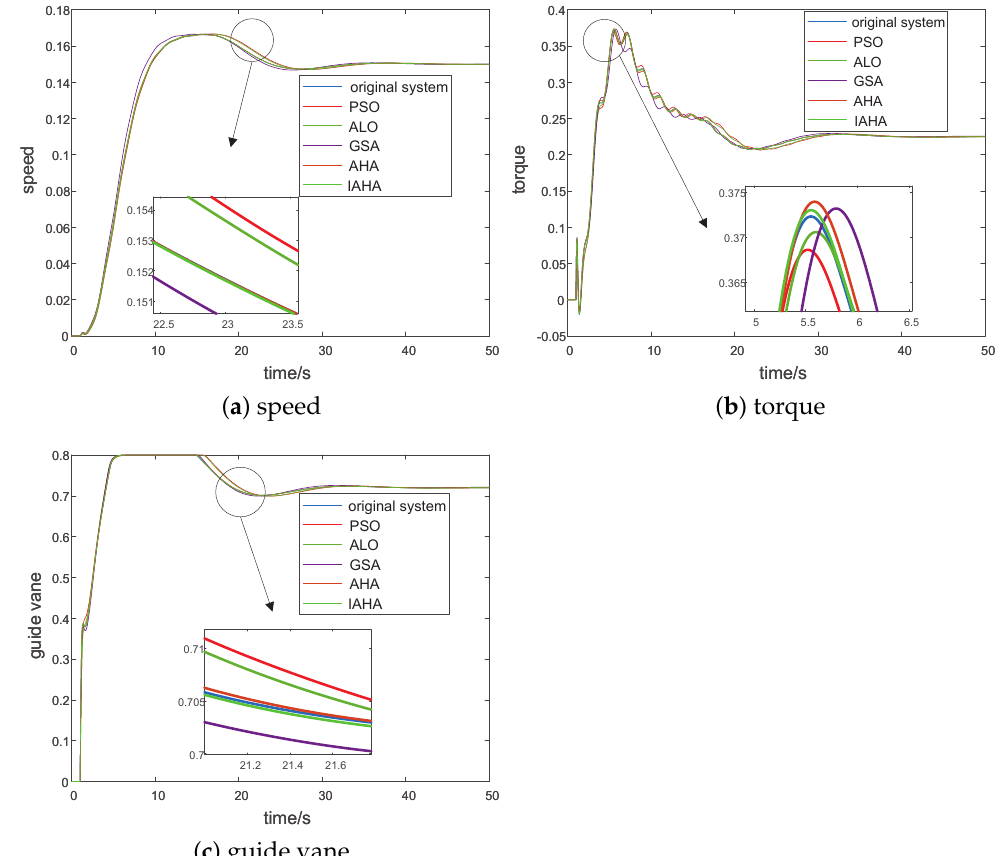
Figure 15. Comparison of the outputs between different optimization algorithms for 15% frequency disturbance